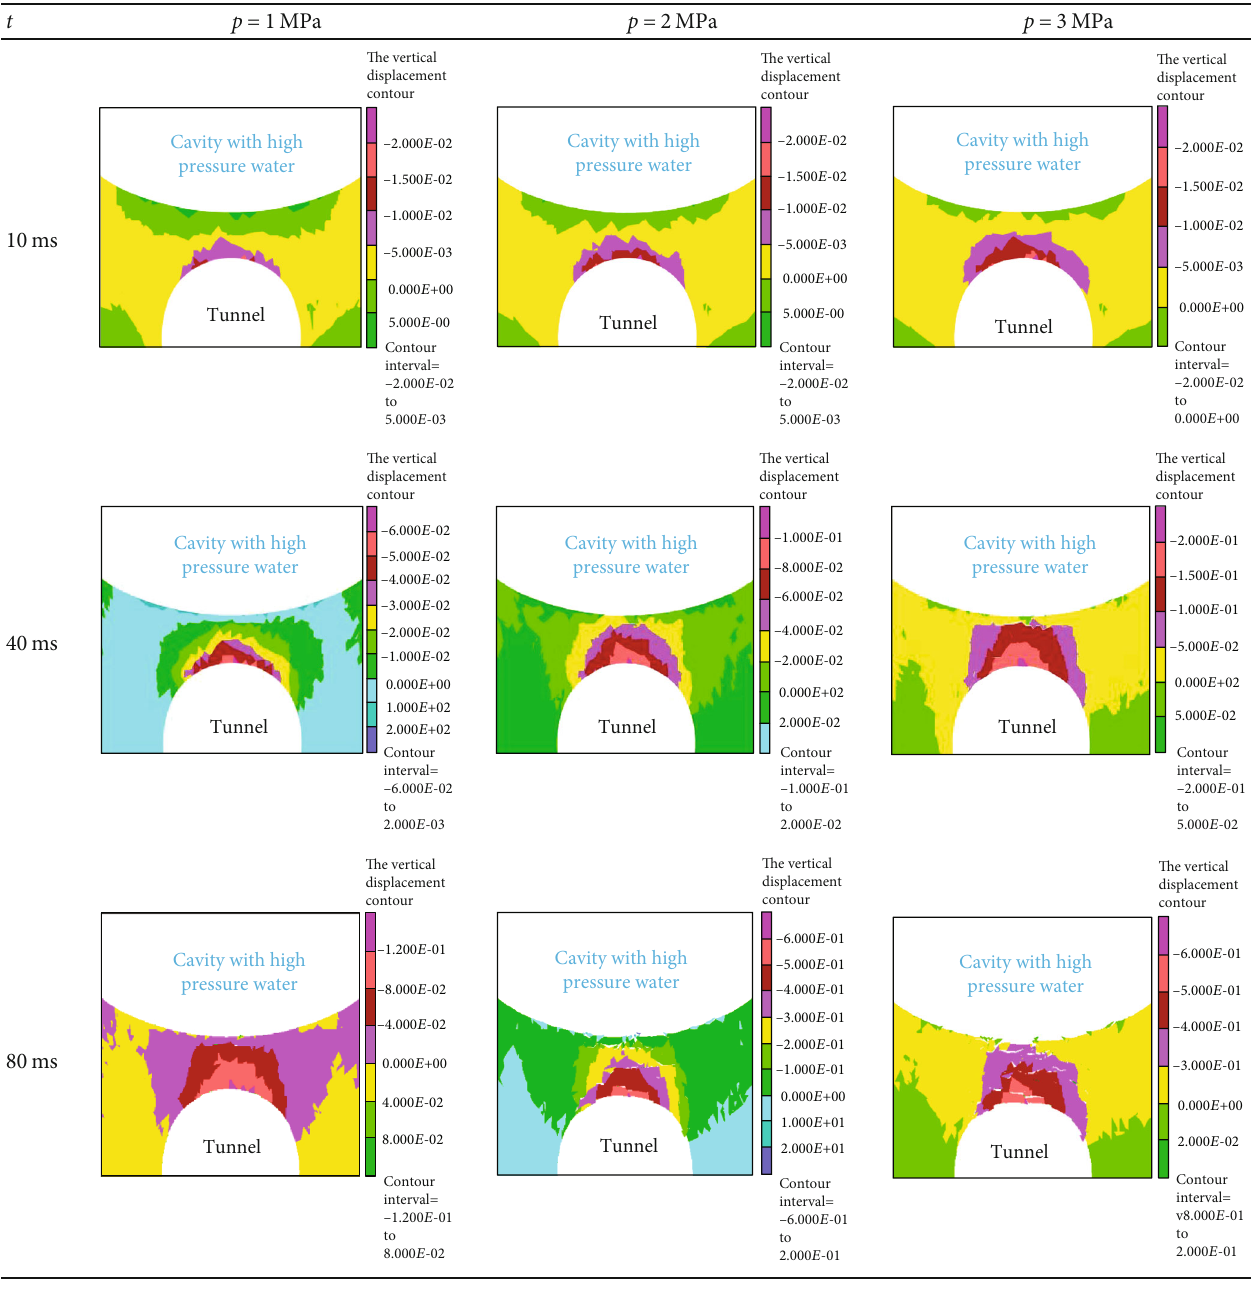
Table 5: The vertical displacement contour under the three cases of p = 1 , 2, and 3MPa at t = 10 , 40, and 80ms. t p = 1 MPa p = 2 MPa p = 3